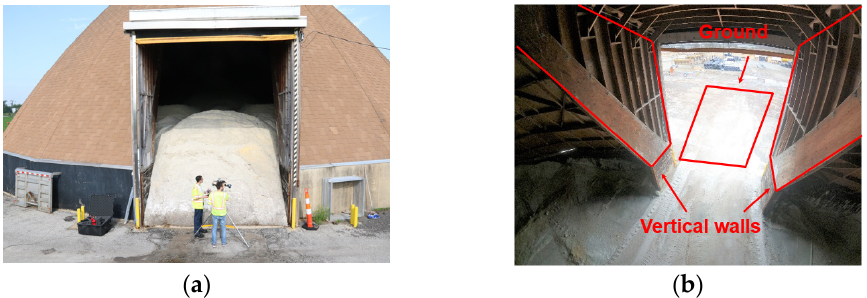
Figure 22. Demonstration of planar features near the entrance of a salt dome facility: (a) tripod- mounted SMART system stationed near the entrance and (b) wall/ground features.